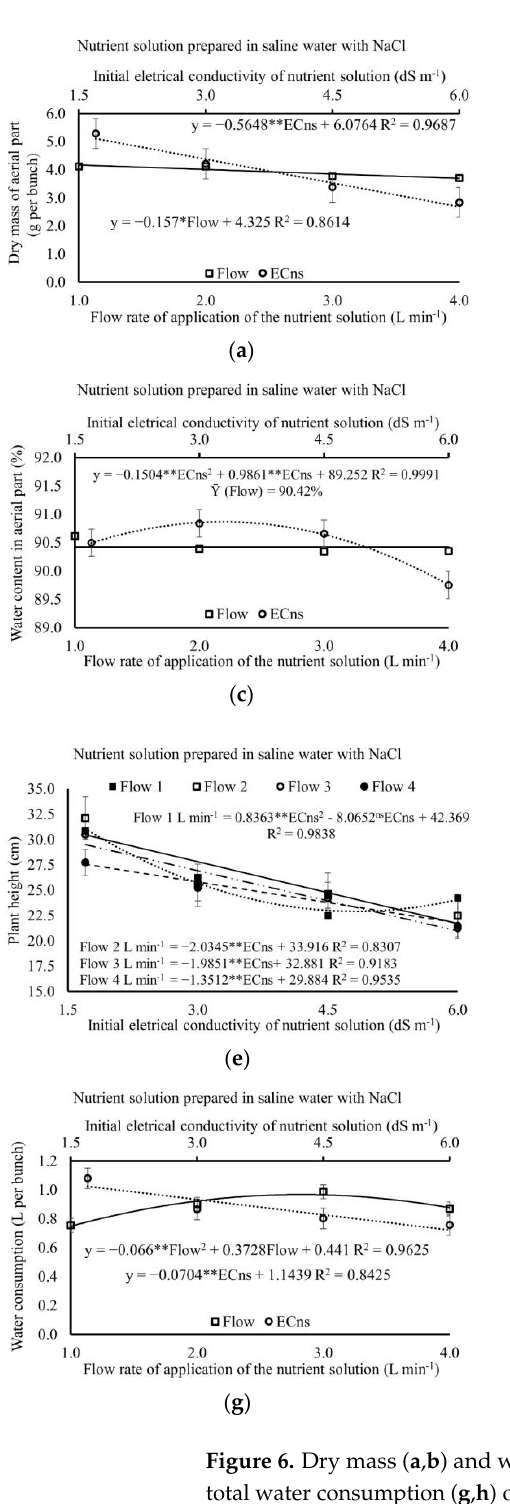
in brackish water, salinized with NaCl and CaCl 2 · 2H 2 O, and applied in crescent flow